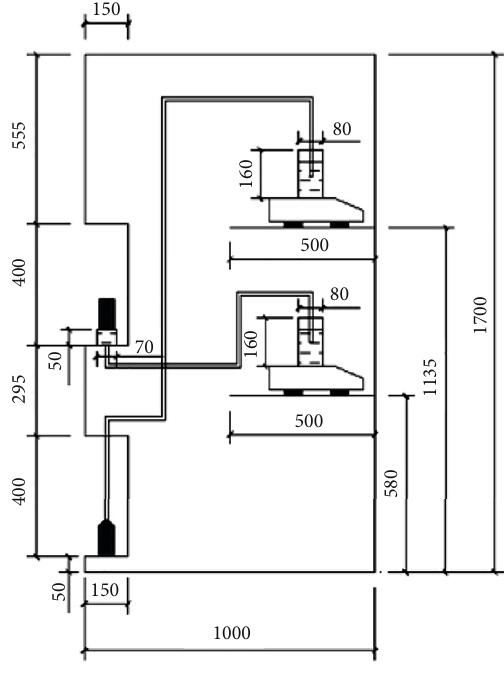
Figure 6: Later view.